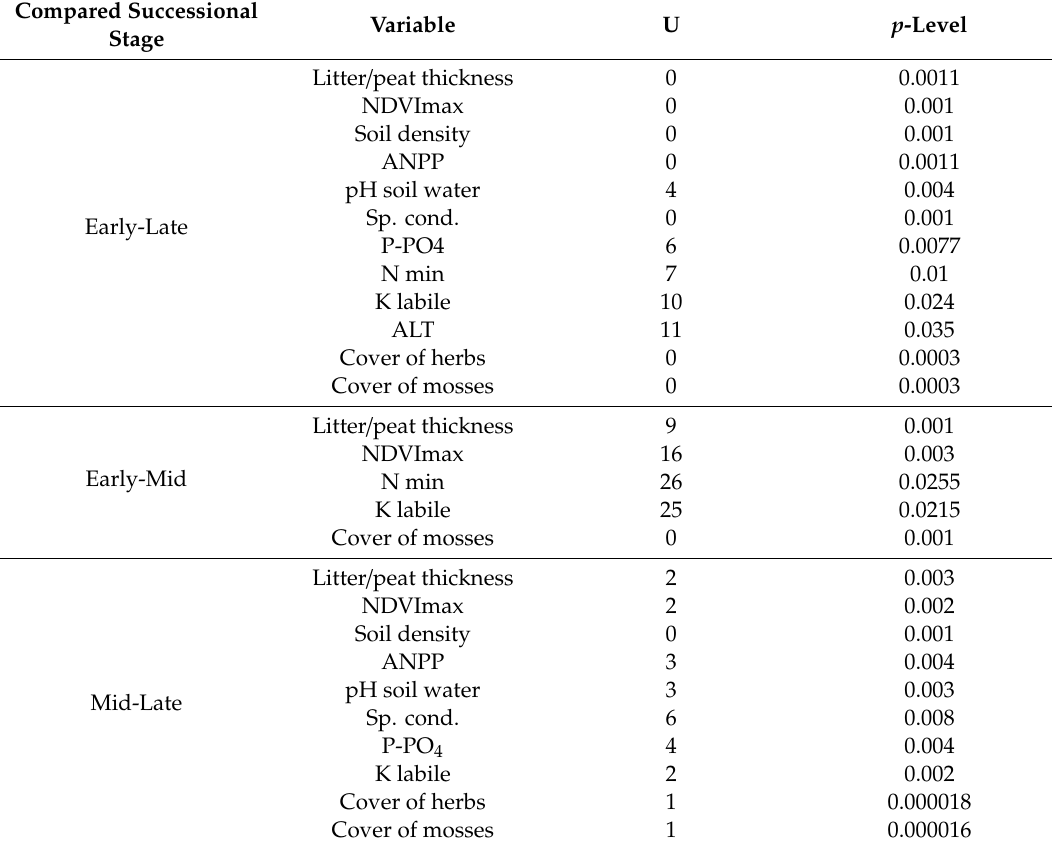
B. Pairwise COMPARISON of successional stages of the khasyreys by soil and vegetation